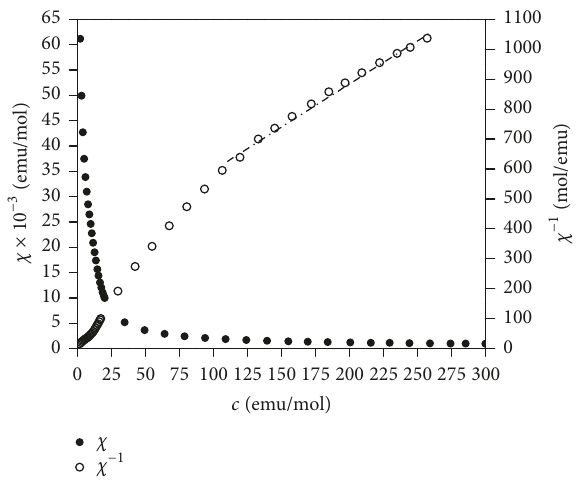
Figure 6: Temperature dependence of 𝜒 for 2 (filled circles) and Curie plot (open circles) with the best fit to Curie-Weiss law (dotted line) at 1000 Oe applied field.